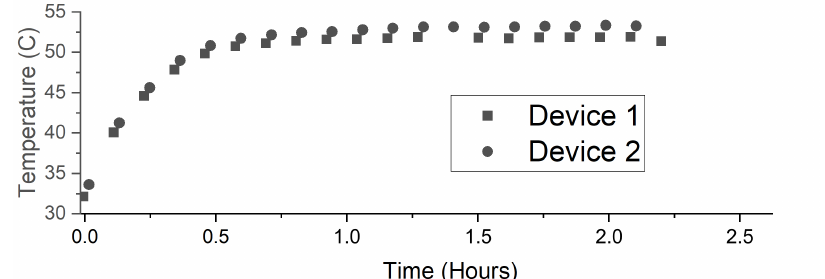
Figure 6. The example temperature measurements from two identical sensing systems during the high-ambient-temperature test where the ambient temperature was ramped up from approximately 32°C to 50°C over a duration of 45 min in a closed chamber.